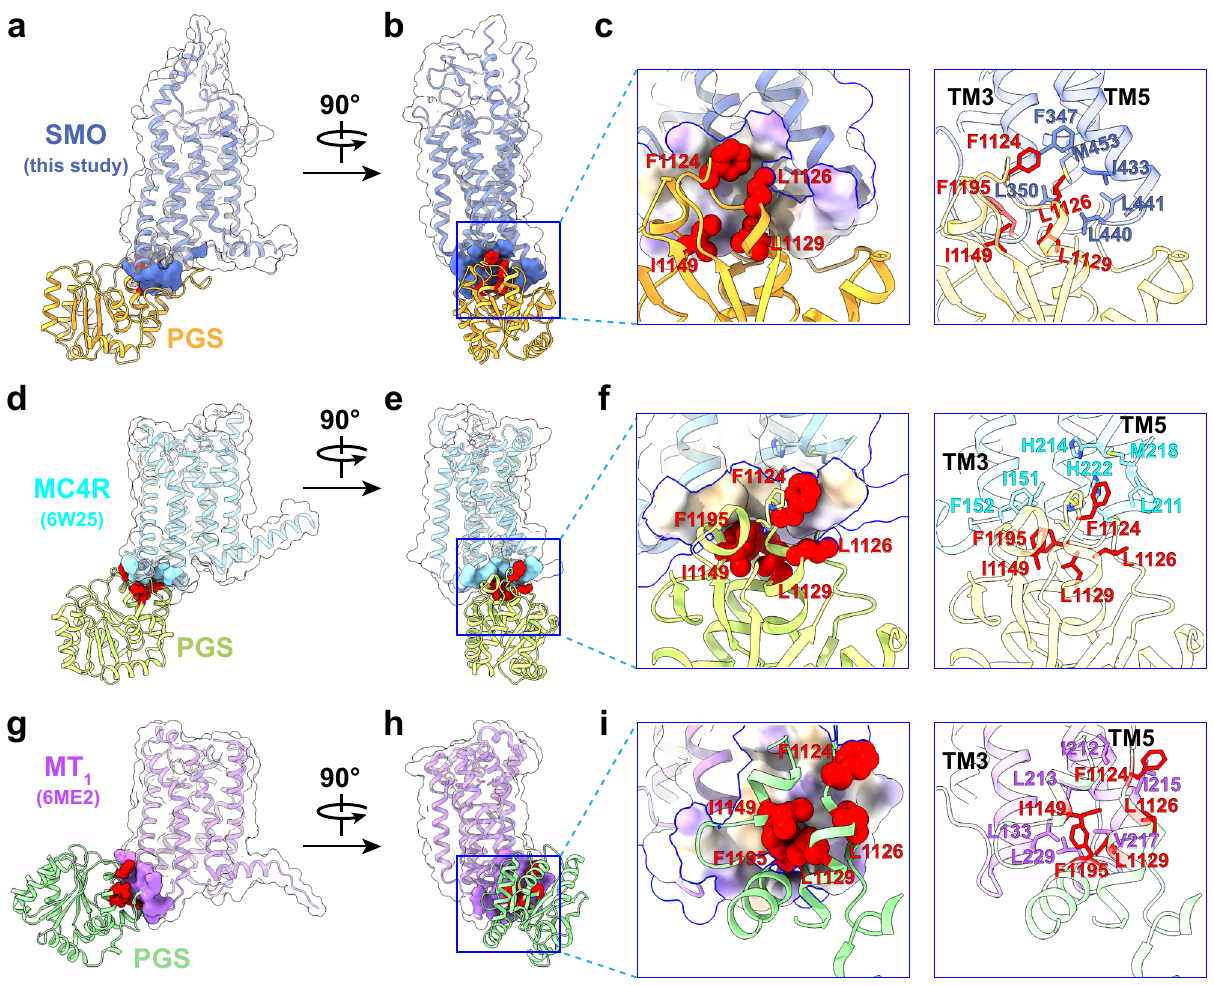
Fig. 3 | Hydrophobic interfaces between SMO/MC4R/MT1 and the PGS fusion protein. a, b Two different views of mSMO-PGS2 structure showing the relative orientationofthereceptorandPGS.ThecontactareaofSMOwithPGSisindicated by blue surface. c An enlarged view of the hydrophobic interactions between mSMO and PGS that facilitate the rigid attachment of PGS, including the key resi- dues in PGS (as sphere on the left) and SMO, respectively. The contact area is colored to show the hydrophobicity. d, e Two different views of MC4R structure